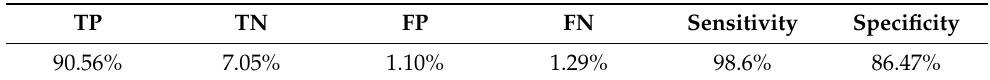
Table 2. Performance for all tumor location ML models. TP = true positive, TN = true negative, FP = false positive and FN = false negative.